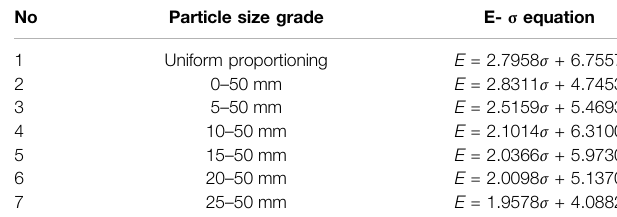
TABLE 3 | Variation of deformation modulus of gangue in different